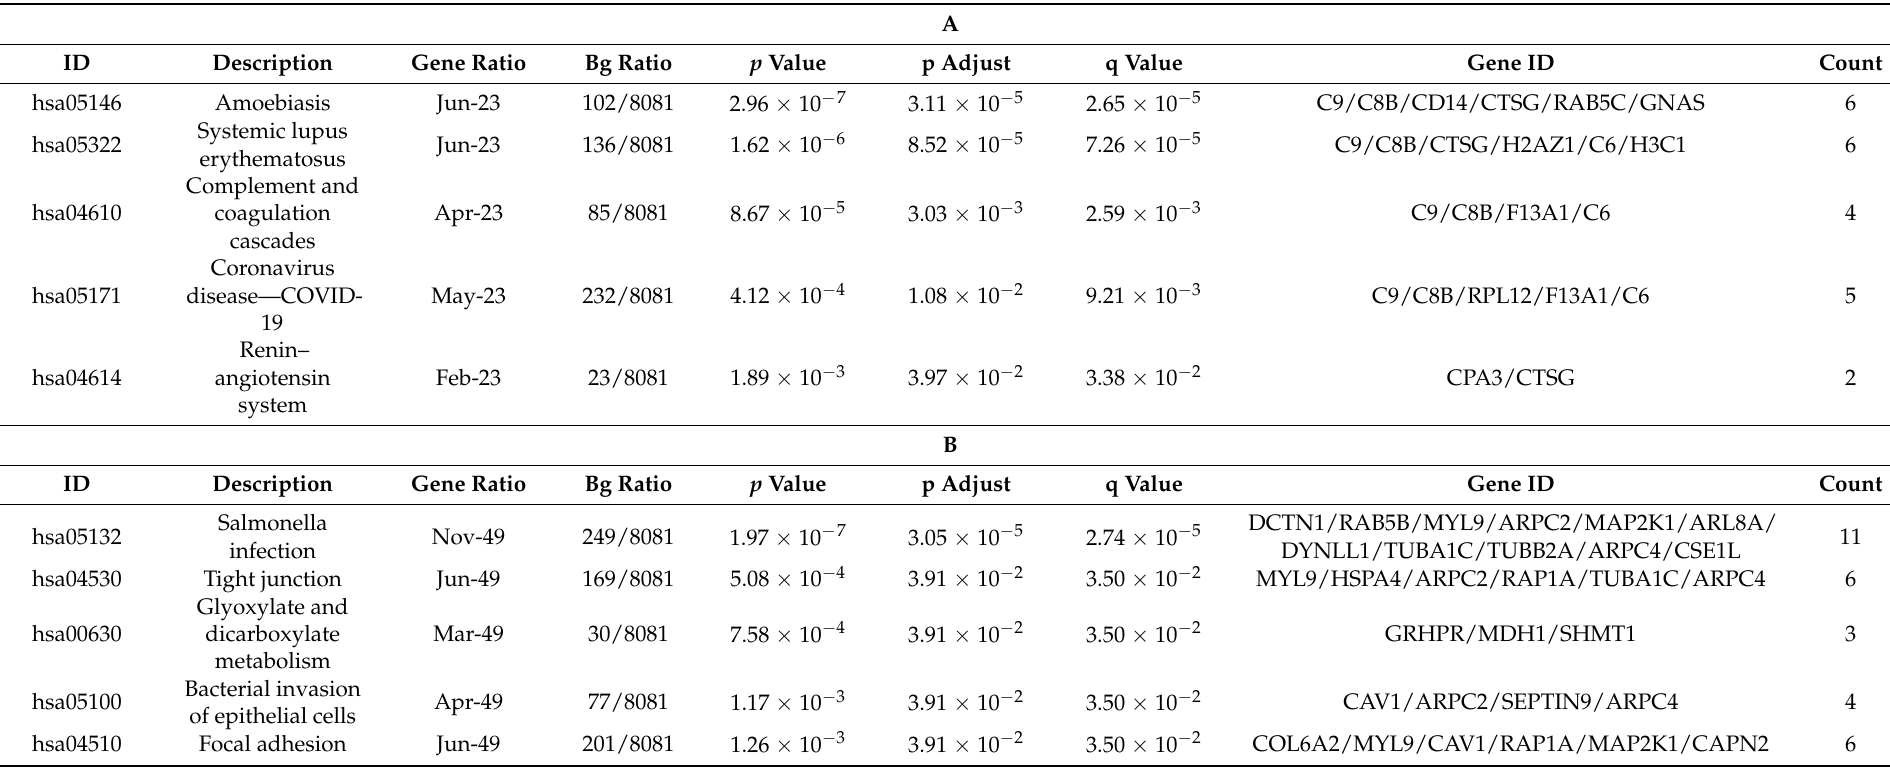
Table 3. Enriched functional signalling networks in the protein sets correlating with previous tumour site (A) and distant tissue (B), respectively, upon principal component analysis (PCA), as well as the most abundant proteins (C) that are present in all tissue-derived exosomal samples and do not differ significantly by site of